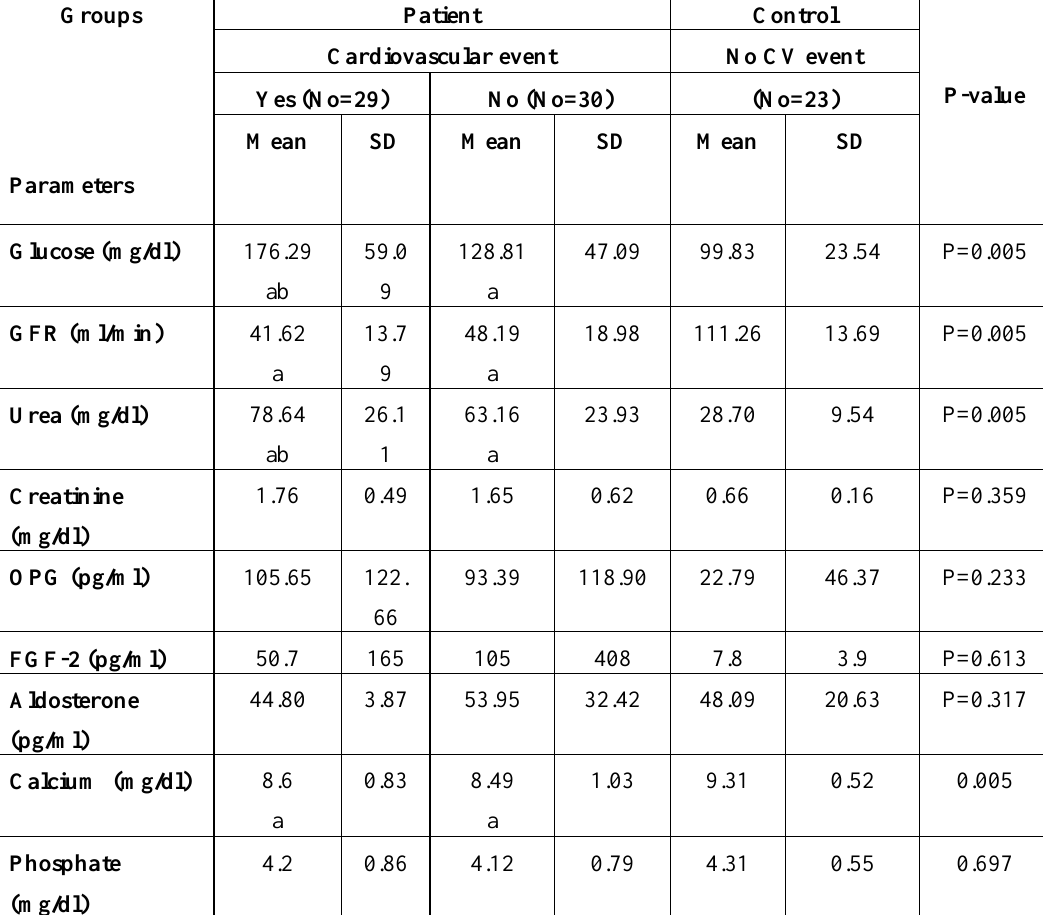
Table3 .Variation in some studied parameters in patients compared to the control subjects according to presence of CV disorder or